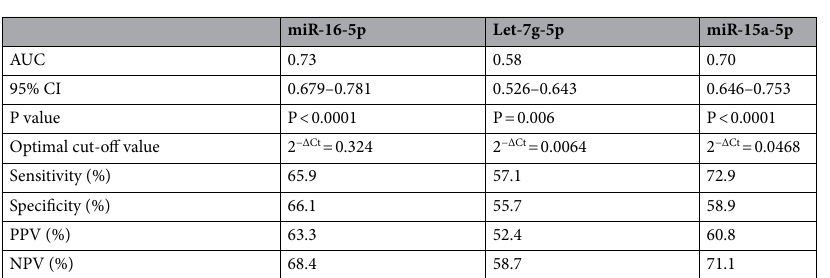
Table 5. Parameters of the receiver operating characteristic curve and predictive value of miRNAs for diagnosing IgAN. AUC, the area under the ROC curve; CI, confidence interval; PPV, positive predictive value; NPV, negative predictive value. IgAN group, n = 174, Disease control ,n = 100, Normal control, n = 97.